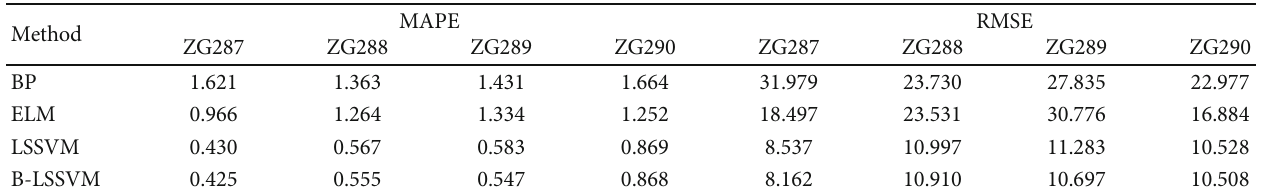
Table 5: Summary of the point prediction results of the displacement of the four GPS monitoring